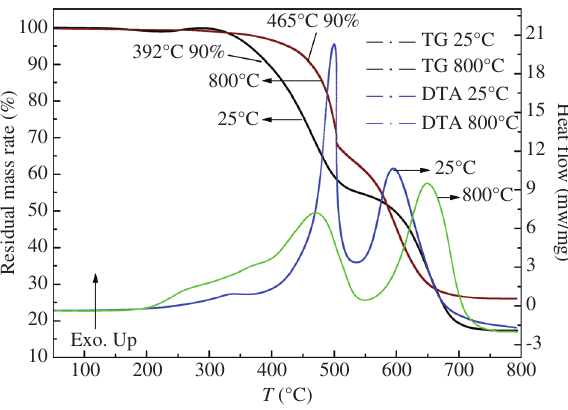
Figure 6 TG and DTA curves of CFRCS before and after